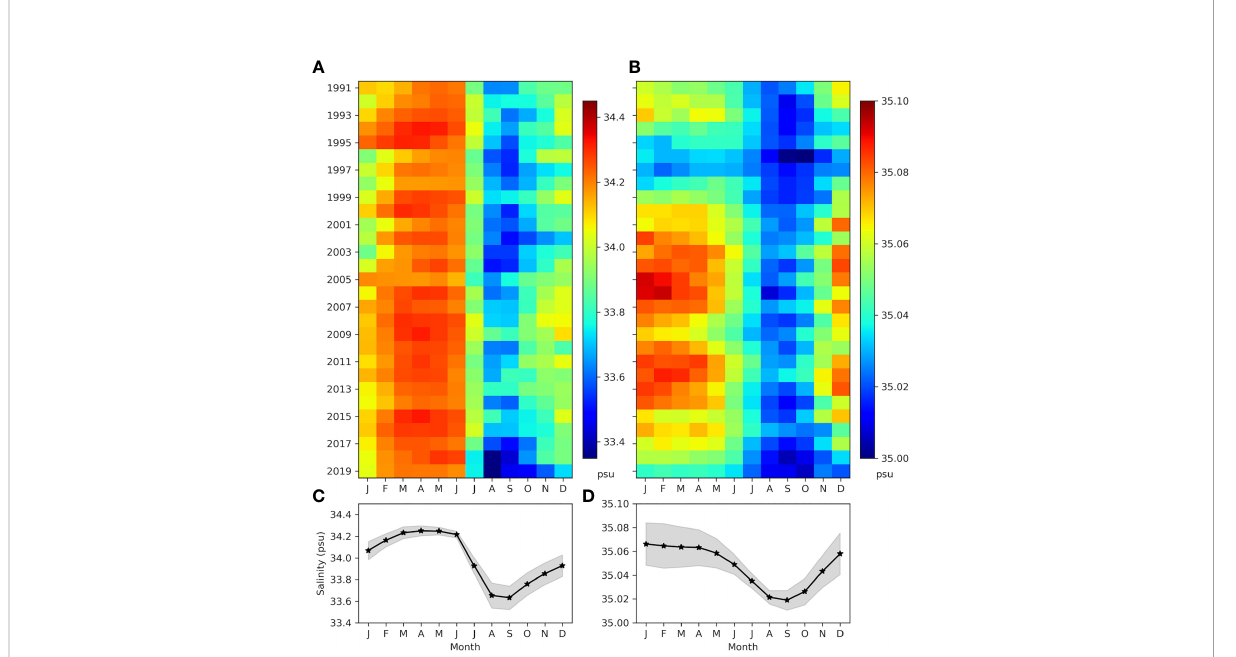
FIGURE 5 Year-month plot of near-surface salinity and its monthly climatology in (A) , (C) the Greenland Sea and (B) , (D) the Norwegian Sea for the period of 1991-2019. Shaded region expresses the standard